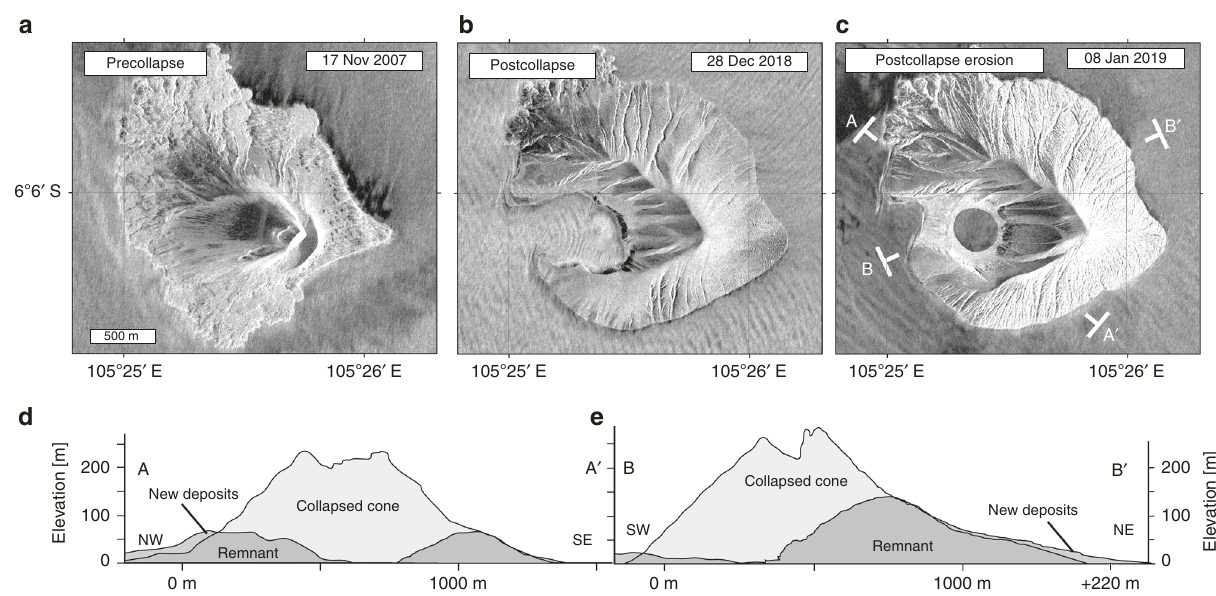
Fig. 5 Morphological changes by sector collapse, material deposition, and subsequent erosion. a – c TerraSAR-X satellite radar images in high-resolution spotlight mode showing the extents of changes associated with sector collapse and with the formation and erosion of the new coastline, tuff ring, and crater lake before and after the 22 December 2018 collapse. d , e Before and after comparison of the morphology deduced from TanDEM-X data (before, light-gray shading) and camera drone data (after, dark gray shading) revealing profound topographic changes, material loss and deposition of new materials. Erosion was carving gullies on the volcano fl anks by early January